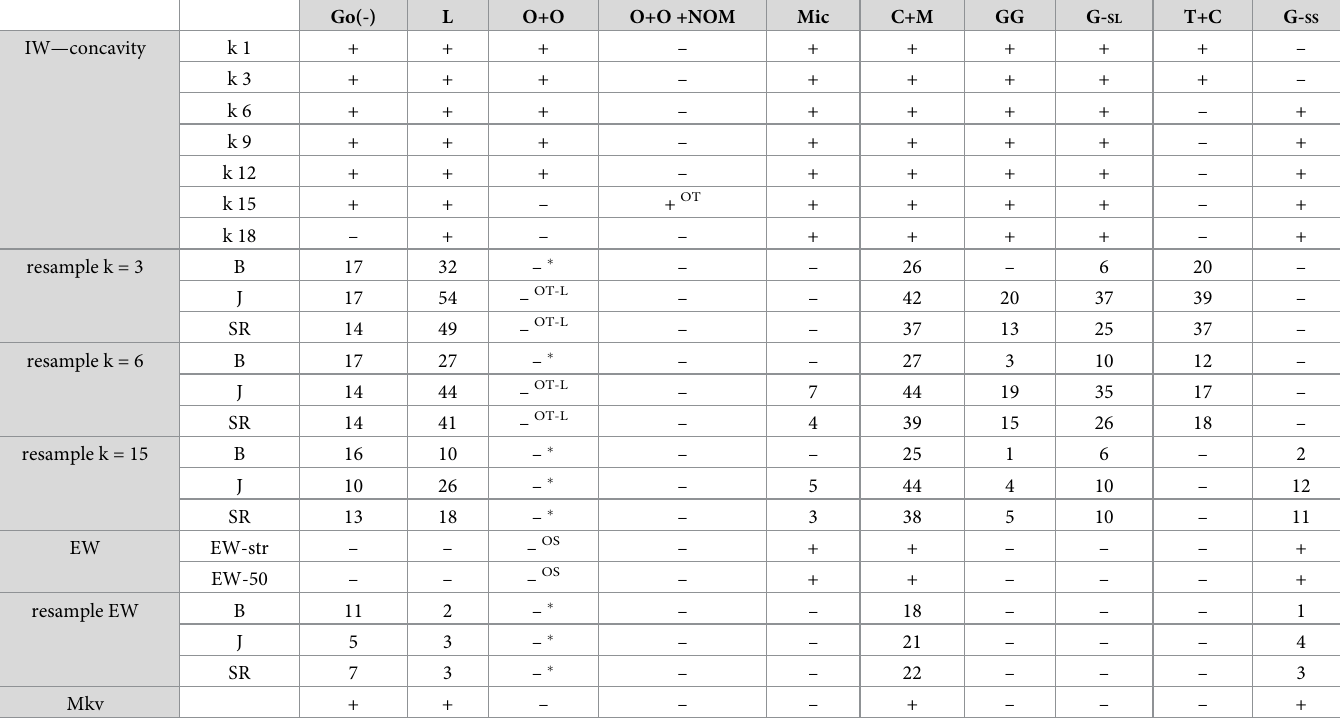
Table 2. Recovery of the relevant clades, monitored in different analytical treatments.